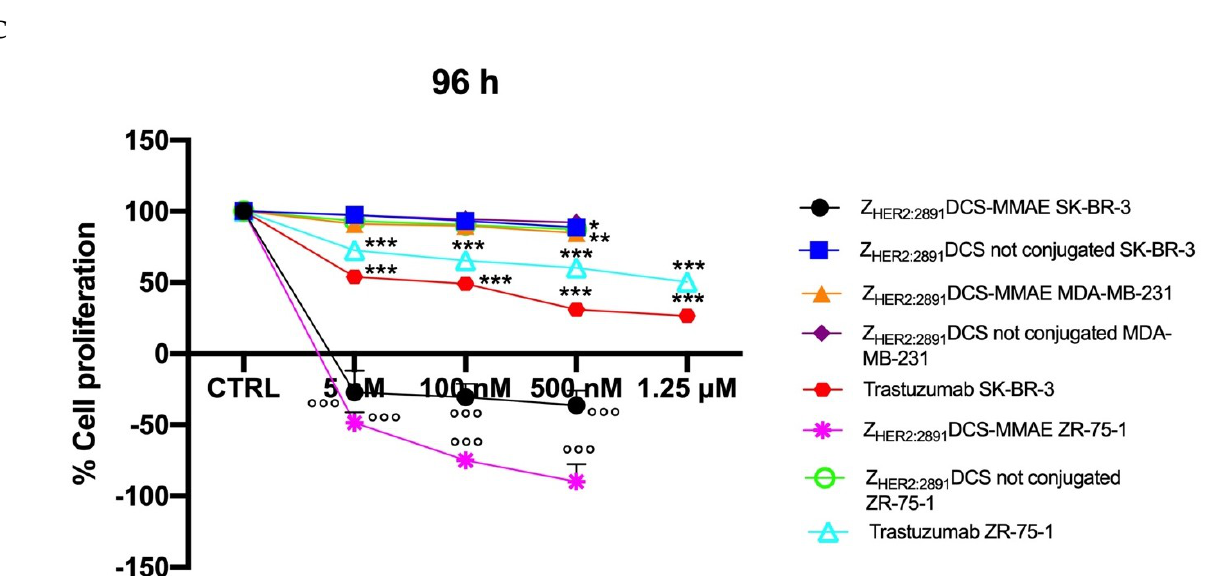
Figure 5. Cell proliferation assay. The effect on cell growth of trastuzumab and Z HER2:2891 DCS-MMAE and not conjugated, was tested in SK-BR-3, ZR-75-1 and MDA-MB-231 cells. Cells were treated with the substances for 24, 48, and 96 h (Panels A , B, and C , respectively). Cell number was measured with a Coulter Counter. The p -value was determined by one-way ANOVA test with Dunnett post hoc test and considered significant for p < 0.05 *, p < 0.01 ** p < 0.001 *** compared to control and p < 0.001°°° compared to Z HER2:2891 DCS not conjugated. Data are presented as mean ± SEM.